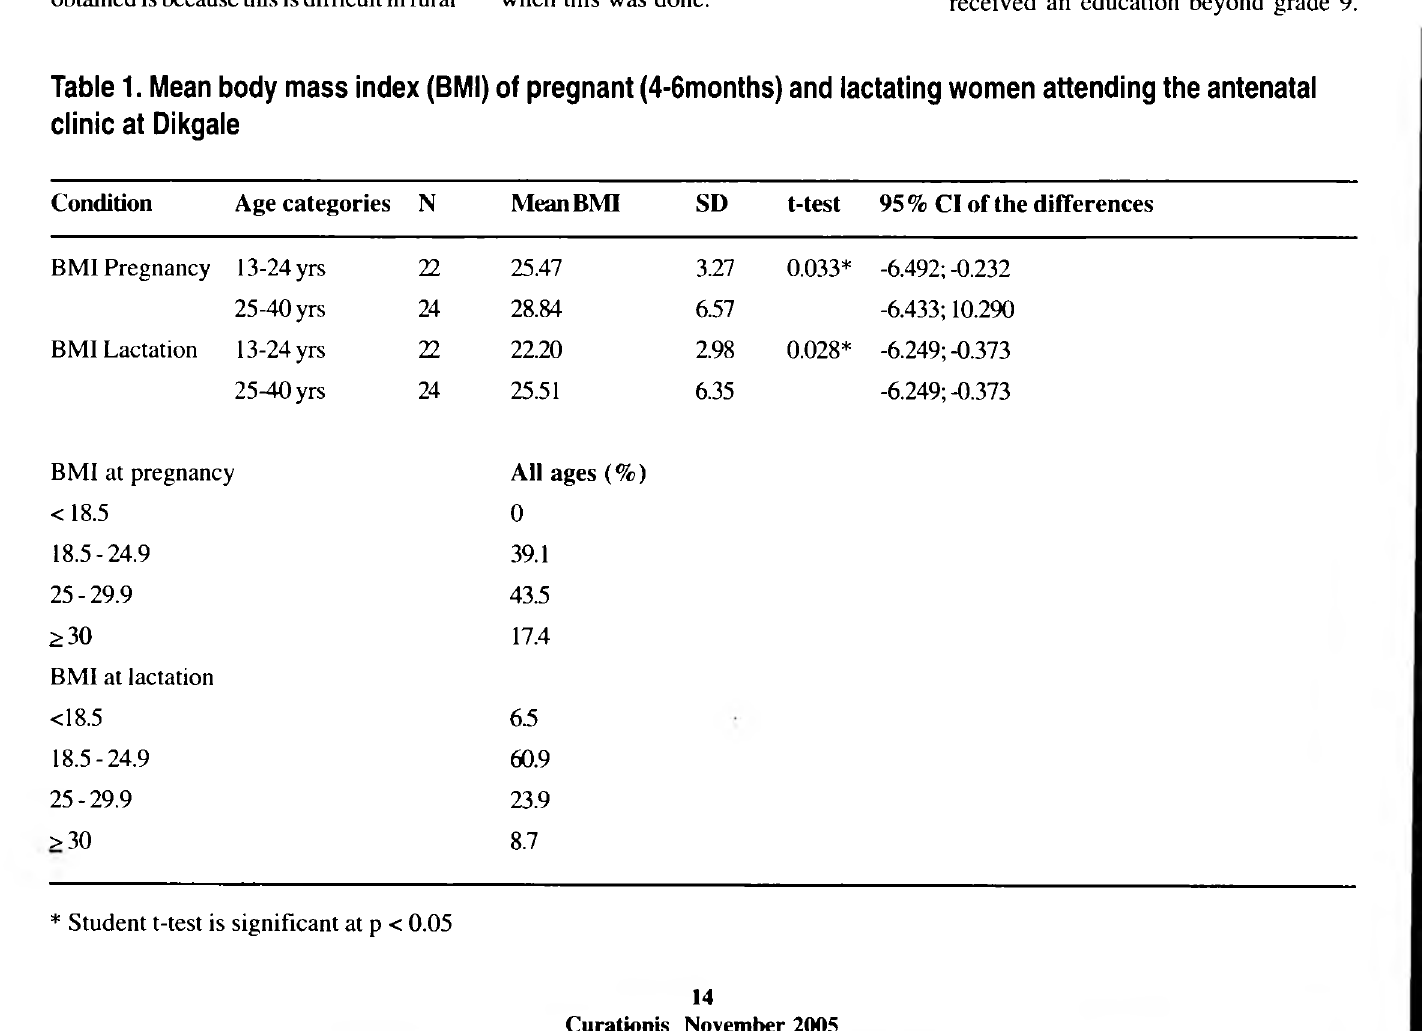
Table 1. Mean body mass index (BMI) of pregnant (4-6months) and lactating women attending the antenatal clinic at Dikgale